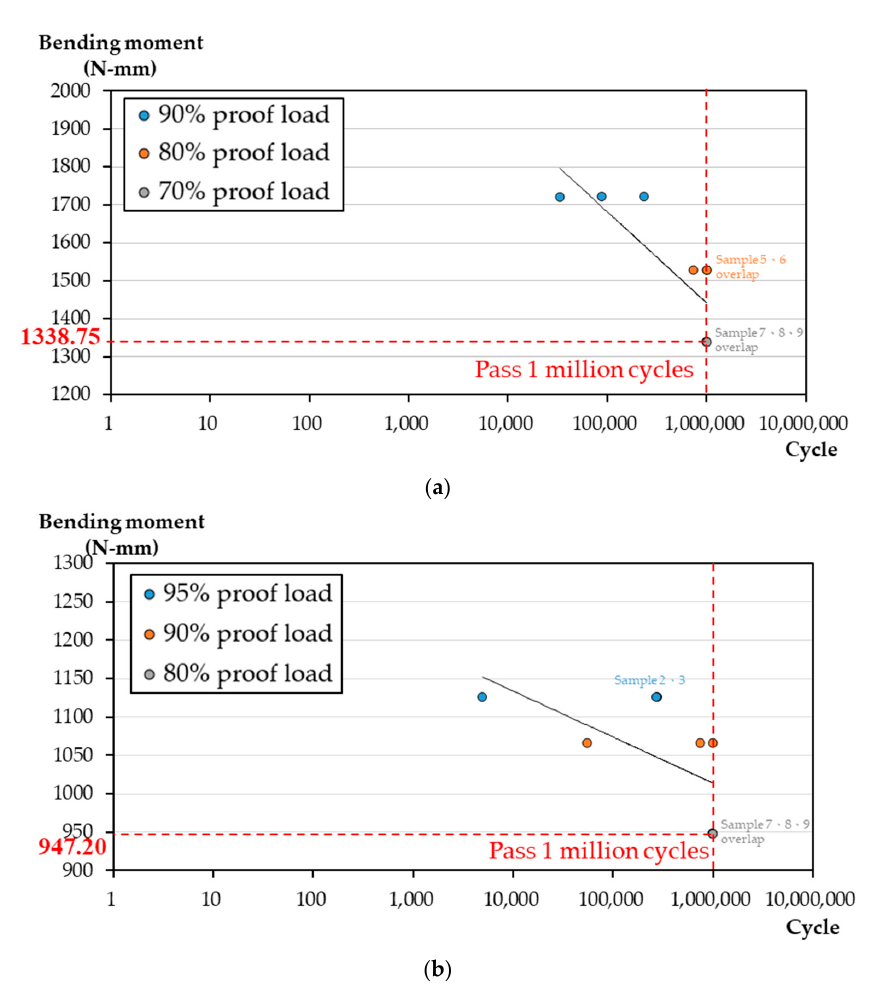
Figure 5. The four-point bending fatigue test M-N diagrams for HDDP and DDP and their corresponding endurance limit ( a ) for HDDP and ( b ) for DDP, i.e., past one-million cycle load. Table 1. Fatigue four-point bending test results for HDDP and DDP.